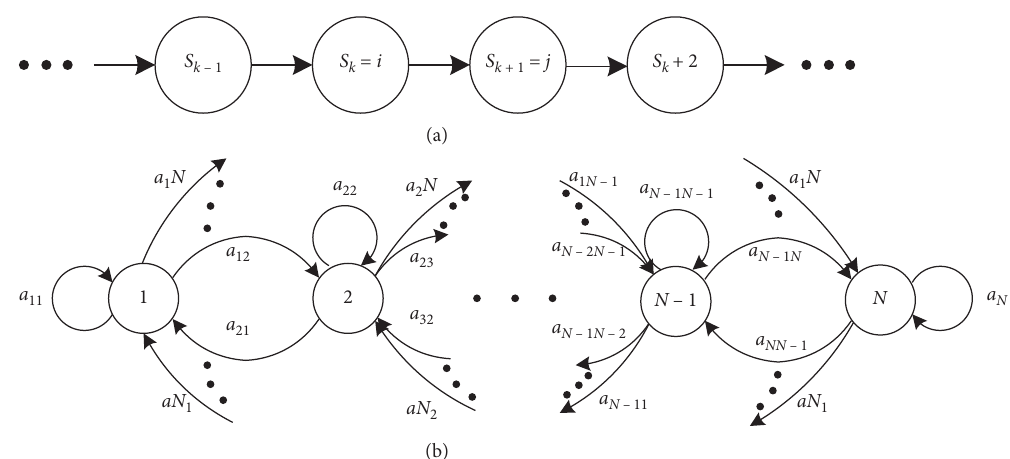
Figure 3: Markov chain for the network states: (a) Markovian property; (b) transition matrix.